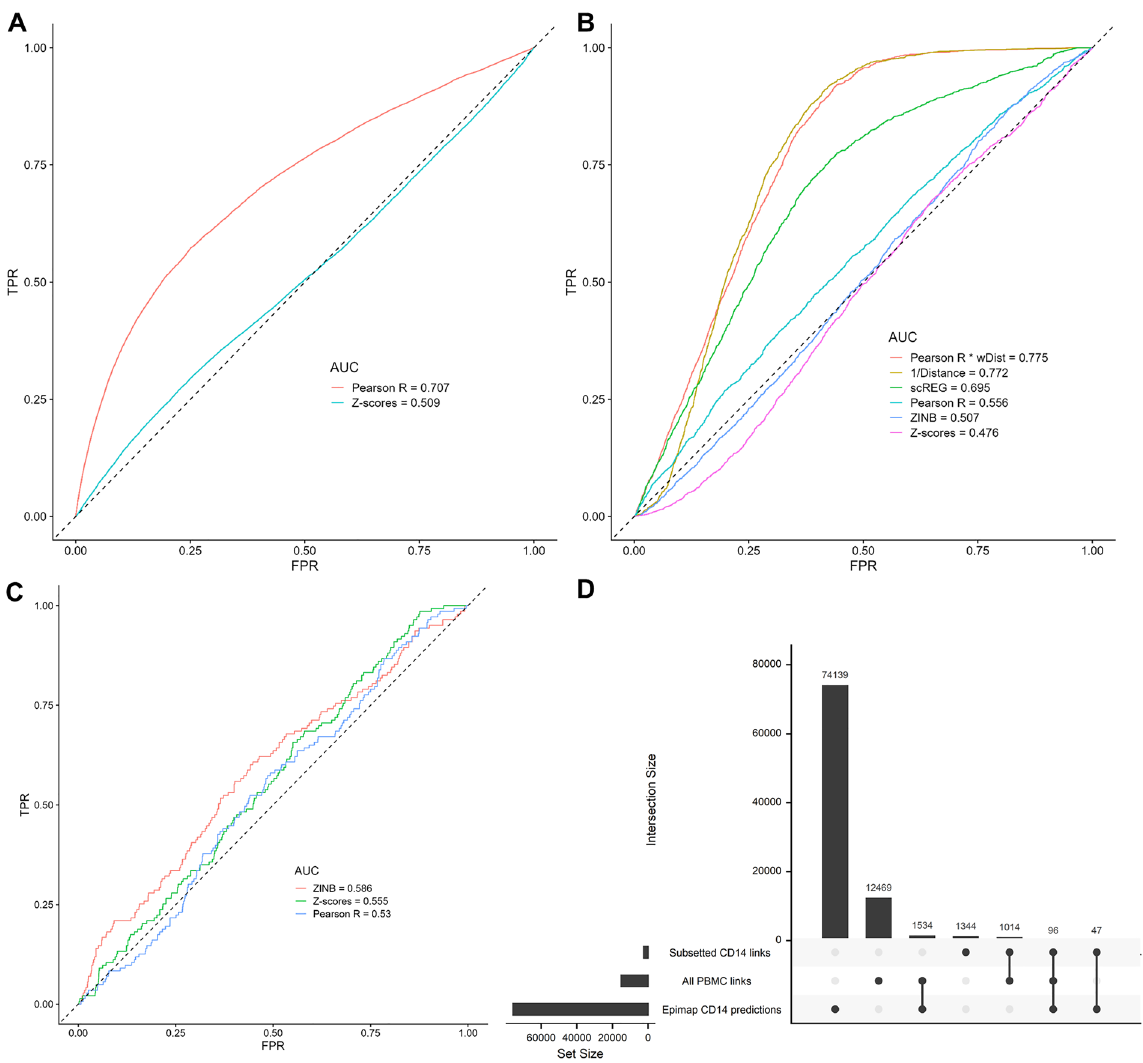
Figure 3. The Pearson R method more accurately validates Epimap-predicted links between cCRE and target genes in CD14 cells. ( A ) We used the Pearson R and Z-scores methods to detect links between ATACseq peaks and target genes (590,842 links with |Pearson R|> 0.01) in the complete (i.e., using all PBMC to compute statistics) PBMC multiomic dataset. Then, we performed Receiving Operating Curves (ROC) analyses to compare the identified peak-gene links from the multiomic data with regulatory links in CD14 cells predicted by the Epimap Project. ( B ) As in ( A ), but using a smaller set of links defined using a more stringent statistical threshold (15,113 links with |Pearson R|> 0.1). All cell-types are used to identify links, except for scREG which by design output link scores by cell-type (in this case, CD14 cells). ( C ) As in ( B ), but limiting these ROC analyses to links between ATACseq peaks and target genes with |Pearson R|> 0.1 that were found in the CD14 cells subset of the PBMC multiomic dataset. ( D ) Upset plot that shows the intersections of links identified between ATACseq peaks and target genes using either the full PBMC multiomic dataset or only the CD14 cells subset with cCRE-gene regulatory links in CD14 cells as predicted by the Epimap Project. ZINB; zero-inflated negative binomial, wDist; weighted distance (e (−distance/200 kb) ), TPR, true positive rate; FPR, false positive to detect peak-gene links. For instance, our analysis of the whole PBMC dataset (i.e., using all PBMC to com- pute statistics) yielded 15,113 peak-gene links with |Pearson R|> 0.1, including 1611 links (10.7%) that overlap with Epimap predictions for CD14 cells. In contrast, when we restricted our analysis to CD14 cells from the PBMC multiomic dataset, we found 2499 links, including 143 (5.7%) also predicted by Epimap in CD14 cells (Fig. 3D). From these observations, we conclude that using all available cells from multiomic experiments to detect links between ATACseq peaks and target genes is a more powerful strategy than limiting the analyses to single cell-type. Finally, we compared the peak-gene links identified in the PBMC multiomic datasets with 644 cCRE-gene pairs that were functionally validated using CRISPR perturbations in different cell models 19 . We found that dis- tance alone (or in combination with the Pearson R coefficient) was the best predictor of links between ATACseq peaks and genes that were consistently validated by CRISPR perturbations (Fig. 4). We also noted that the simple